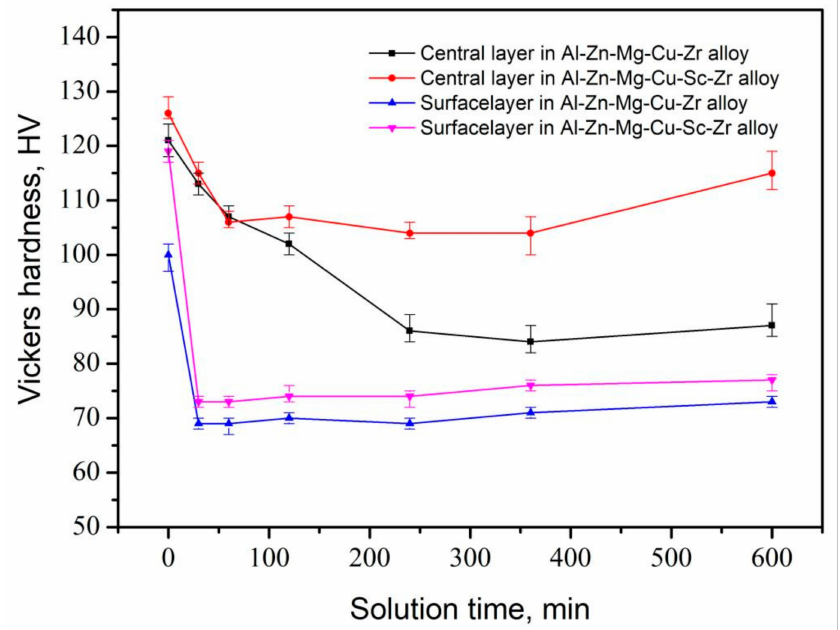
Figure 4. Vickers hardness variation curves of Al-Zn-Mg-Cu alloys in the central and surface layers as the solution time is prolonged at 470 ◦